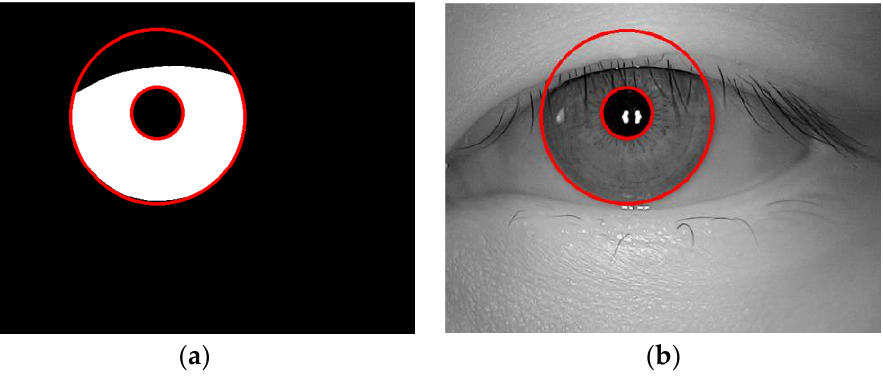
Figure 6. Iris mask localization image and its corresponding original iris localization image: ( a ) mask localization image; ( b ) original iris localization